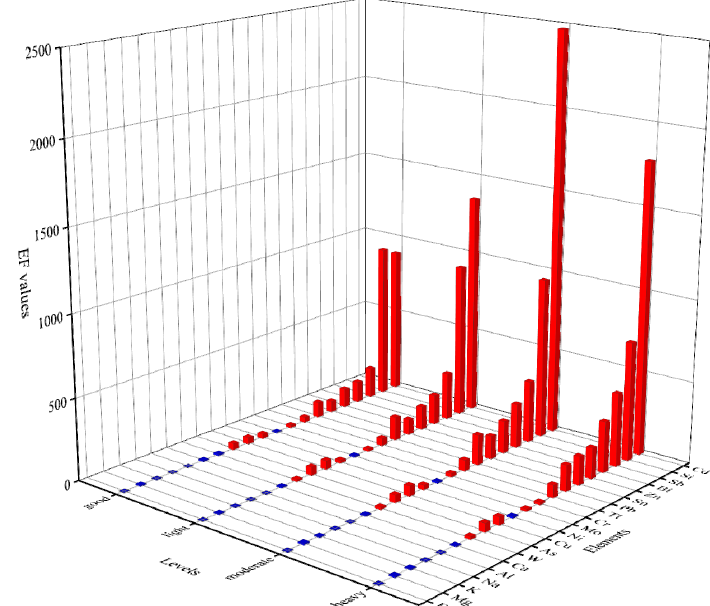
Figure 8. Enrichment factors of elements in four pollution days (red column ≥ 10, blue column < 10; The x-axis, y-axis, and z-axis represent different pollution levels, elements, and enrichment factor (EF) values, respectively).